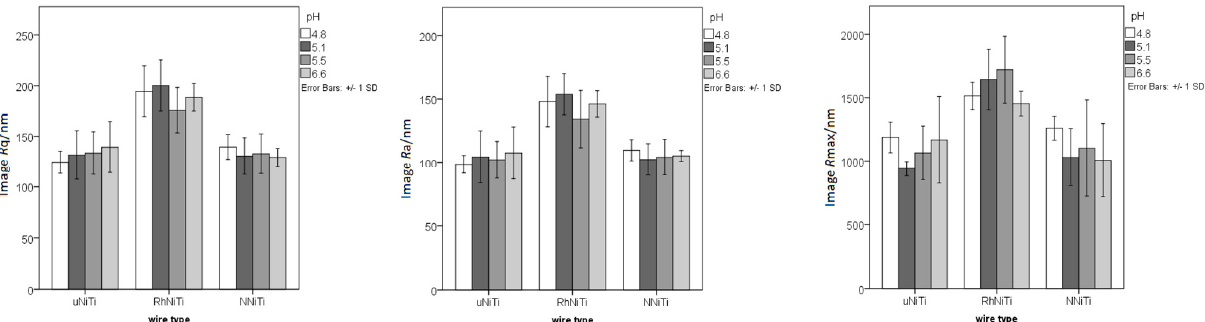
Figure 1. The surface roughness parameters (axis y: R q/nm, R a/nm, R max/nm) for the uncoated NiTi (uNiTi), rhodium-coated NiTi (RhNiTi), and nitrified NiTi (NNiTi) wires after immersion in artifi- cial saliva with four different pH